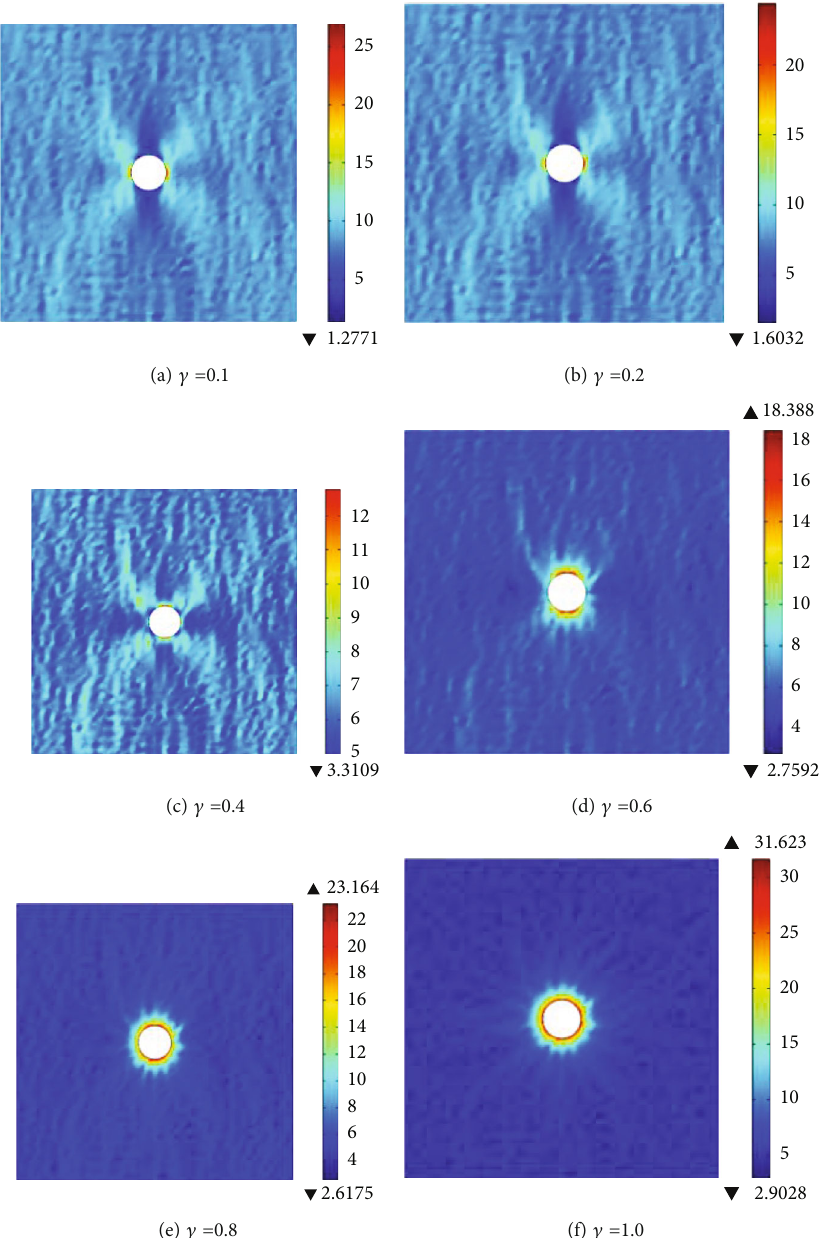
Figure 10: The Mises stress distribution under unequal con fi ning